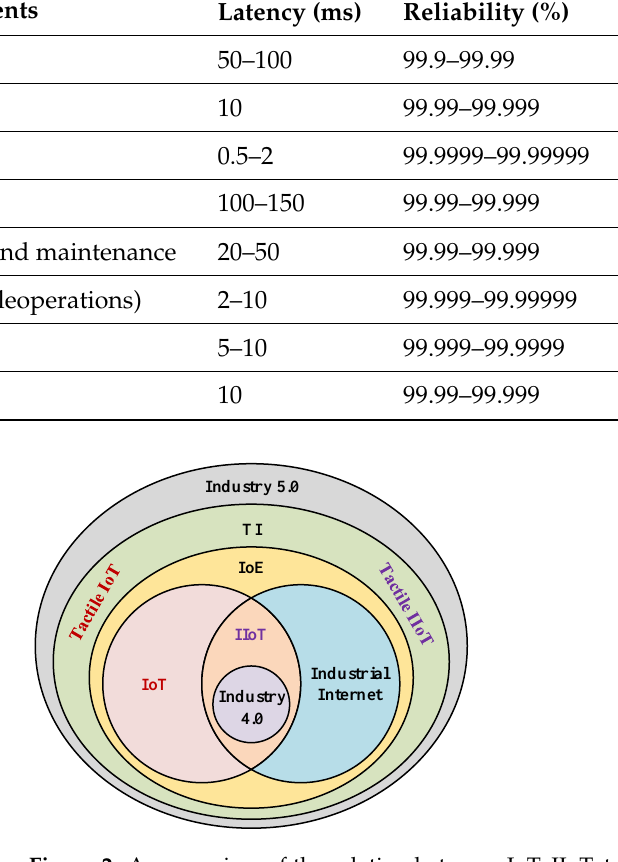
Figure 2. An overview of the relation between IoT, IIoT, tactial IoT, tactile IIoT, Industry 4.0, and Industry